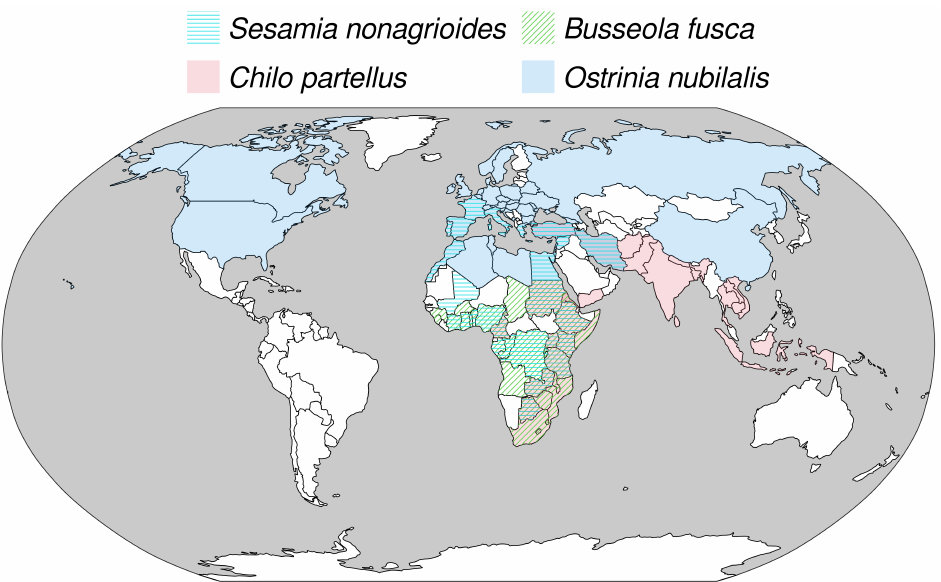
Figure 1. Distribution map of Chilo partellus , Busseola fusca , Sesamia nonagrioides and Ostrinia nubilalis . The map shows the countries where the presence of each species has been recorded in the literature, based on records gathered by the Centre for Agricultural Bioscience International shared under license CC BY-NC-SA 3.0 [45]. There are overlaps between the four distribution ranges, shown by the superposition of colors, particularly in Africa, where S. nonagrioides , B. fusca and C. partellus are